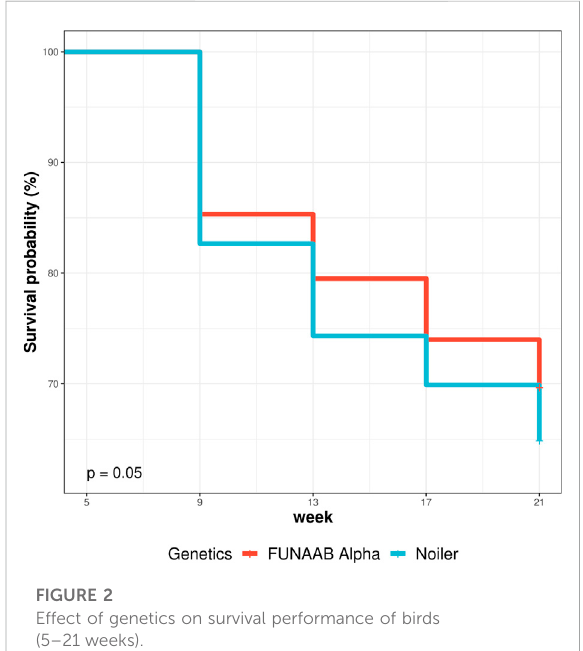
FIGURE 2 Effect of genetics on survival performance of birds (5 – 21